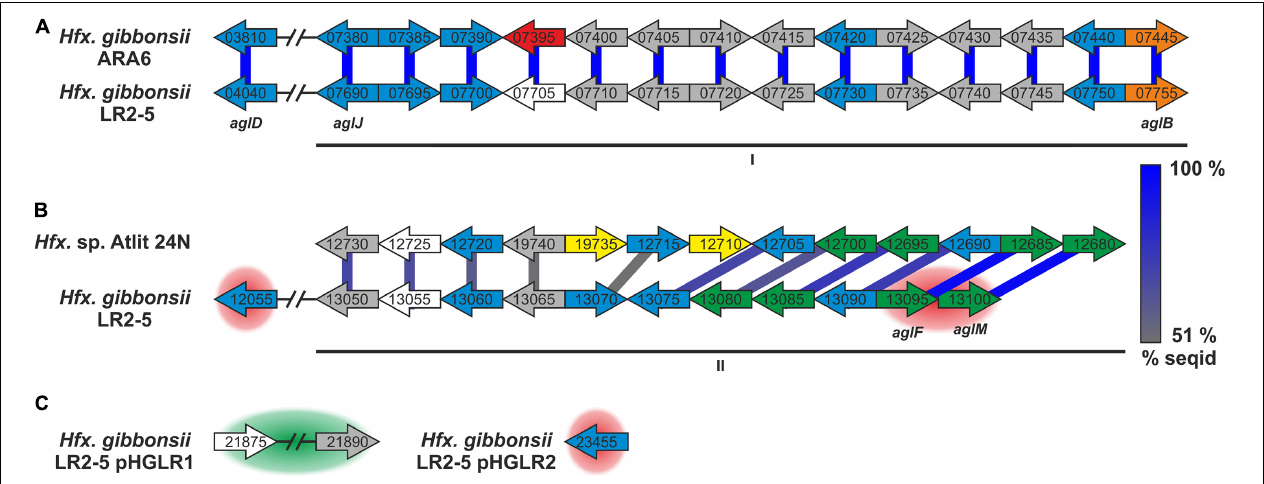
FIGURE 5 | Hfx. gibbonsii LR2-5 N-glycosylation genes with comparison to their closest homologs. Genes are located in two clusters (marked as I and II in A,B ) with some genes being located apart, e.g., on a plasmid (C) . Close homologs in Hfx. volcanii are indicated with the corresponding agl name. Predicted protein function is indicated by color code; blue: glycosyltransferase, red: flippase, white: rfbX family protein (potential flippase), orange: oligosaccharyltransferase, green: sugar modification enzyme, gray: not directly related to N-glycosylation, yellow: hypothetical protein/pseudogene not apparently related to glycosylation. Protein homology and sequence identity are indicated by colored bars. Bar color indicates the level of amino acid sequence identity (see the color coding on the right). Background coloring indicates additional close homologs, red: Hfx. gibbonsii ARA6, green: Hfx. sp. Atlit-16N and Atlit-10N. Gene sizes are arbitrary.